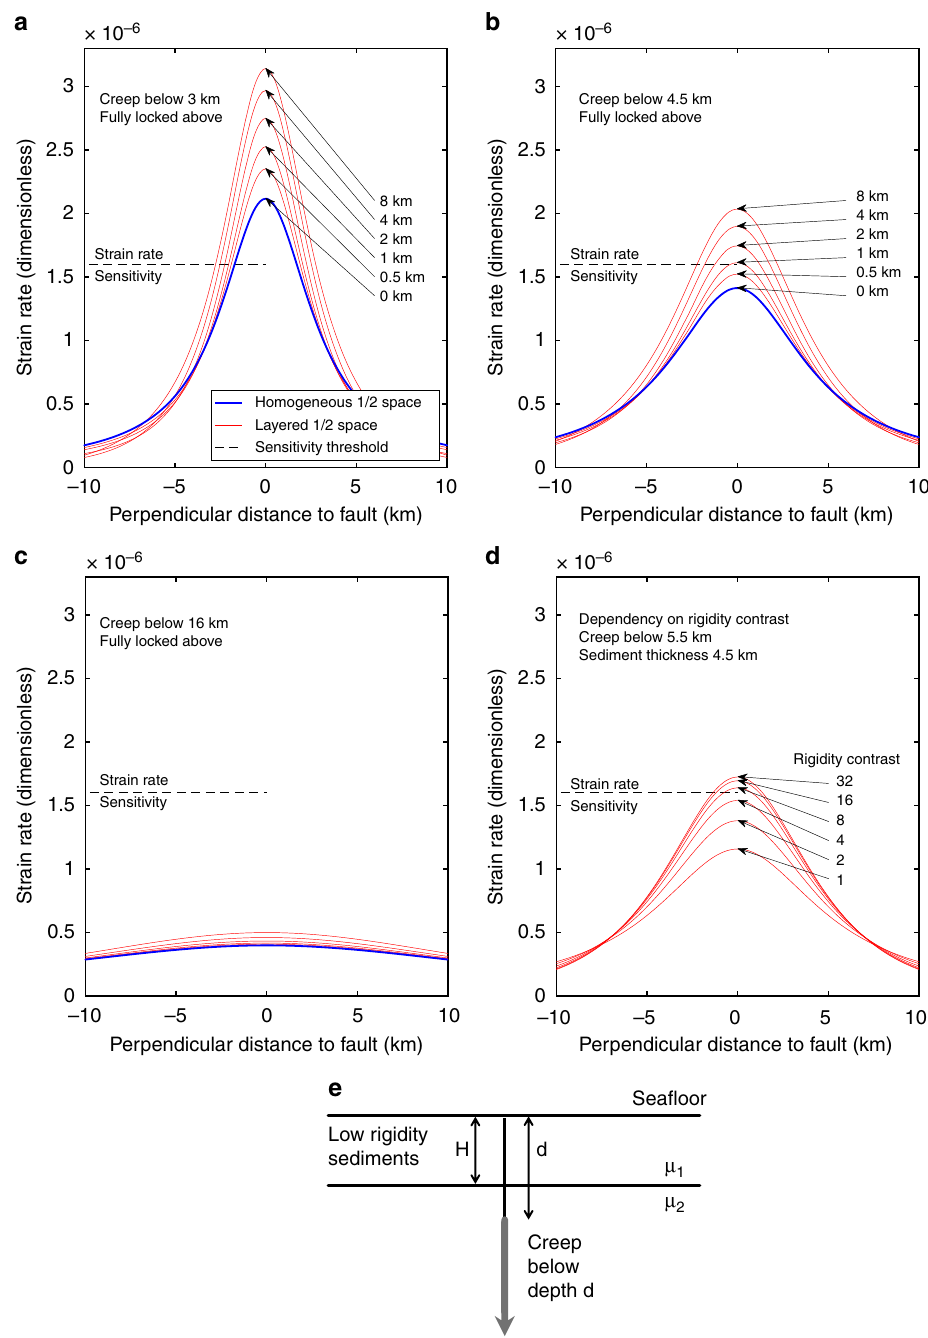
Fig. 5 Modelled strain rates for a vertical strike-slip fault. The strain for homogenous and layered half space, based on elastic dislocation theory, was estimated using the analytical solution for a horizontally layered half-space and a vertical strike-slip fault 37 . a Model for creeping below 3 km depth corresponding to slip in the pre-kinematic basement rocks 36 and below. Above the locking depth, the fault is fully locked. Below the locking depth, the fault creeps at 20 mm yr − 1 . The ratio of rigidity between the lower and upper layer is 4. The strain rate sensitivity of the geodetic network is 1.6*10 − 6 yr − 1 , corresponding to strike-slip movement of 0.8 mm yr − 1 considering a 500 m extension of the geodetic network perpendicular to the fault. b Model for slip below 4.5 km in the basement rocks 36 . c Creep below 16 km depth corresponding to interseismic deformation. d Dependency of rigidity contrast on the strain rate for a 4.5 km weak layer and creep below 5.5 km. Rigidity contrast from empirical relations is in the range between 8 and 16 (Supplementary Table 2). e Sketch showing the modelling setup and parameters. μ 1 and μ 2 are the rigidities of the shallow layer and slip de fi cit for a larger rupture involving all unbroken and locked and with the magnitudes of historical events along the NAF 1,3 and can be considered as a major hazard for the close-by Istanbul segments in the Sea of Marmara Istanbul (e.g. rupture of the NAF metropolitan area and its 15 million inhabitants. in the Kumburgaz Basin and CB, Fig. 1) equals a moment Previous studies assumed a complete locking of the NAF in the magnitude 7.4 earthquake passing 25 km South of the city center eastern Sea of Marmara based on onshore observations since of Istanbul. The magnitudes are in-line with previous studies 29,46